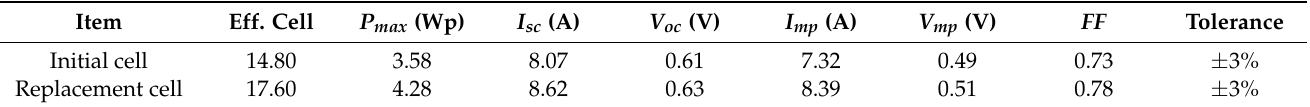
Table 4. Electrical data of initial cell and replacement